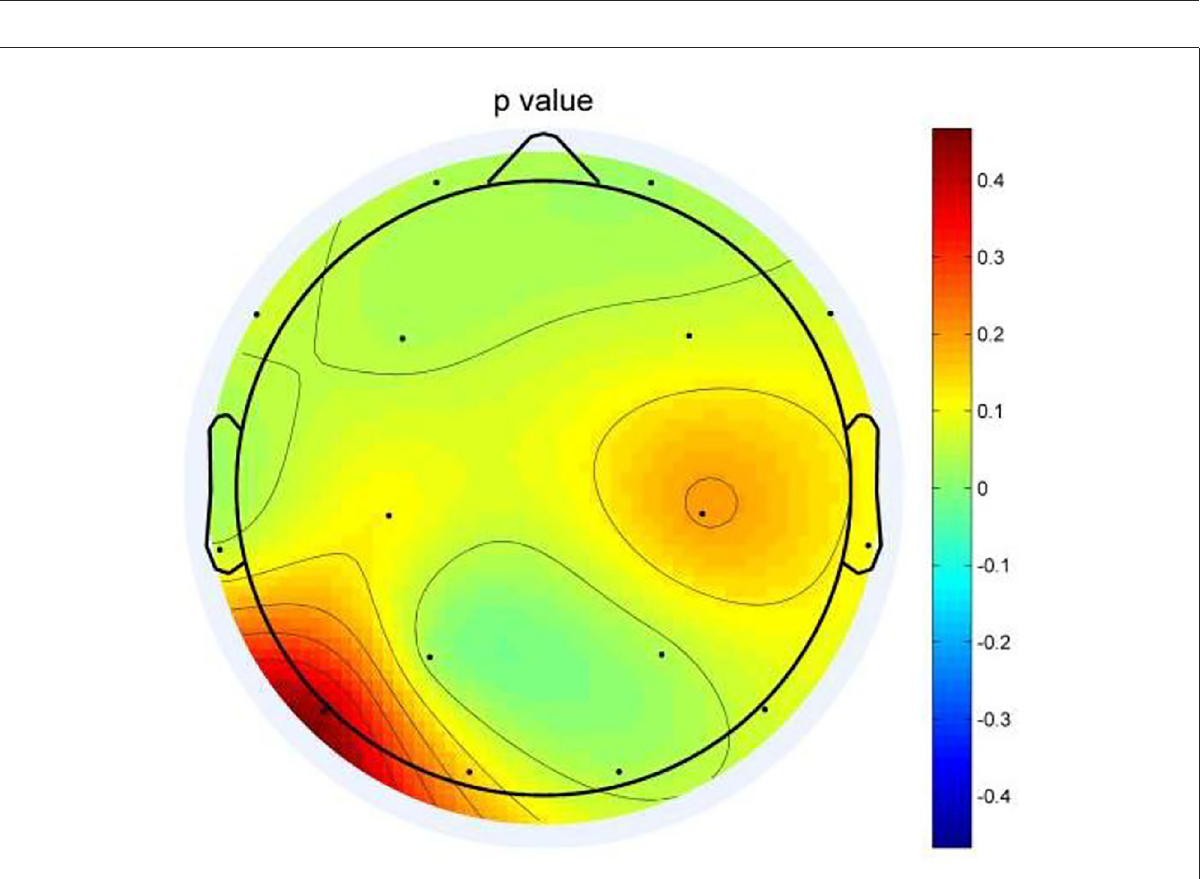
FIGURE2 Topographic map of P -values between the two groups. Green areas represent significant differences ( P <